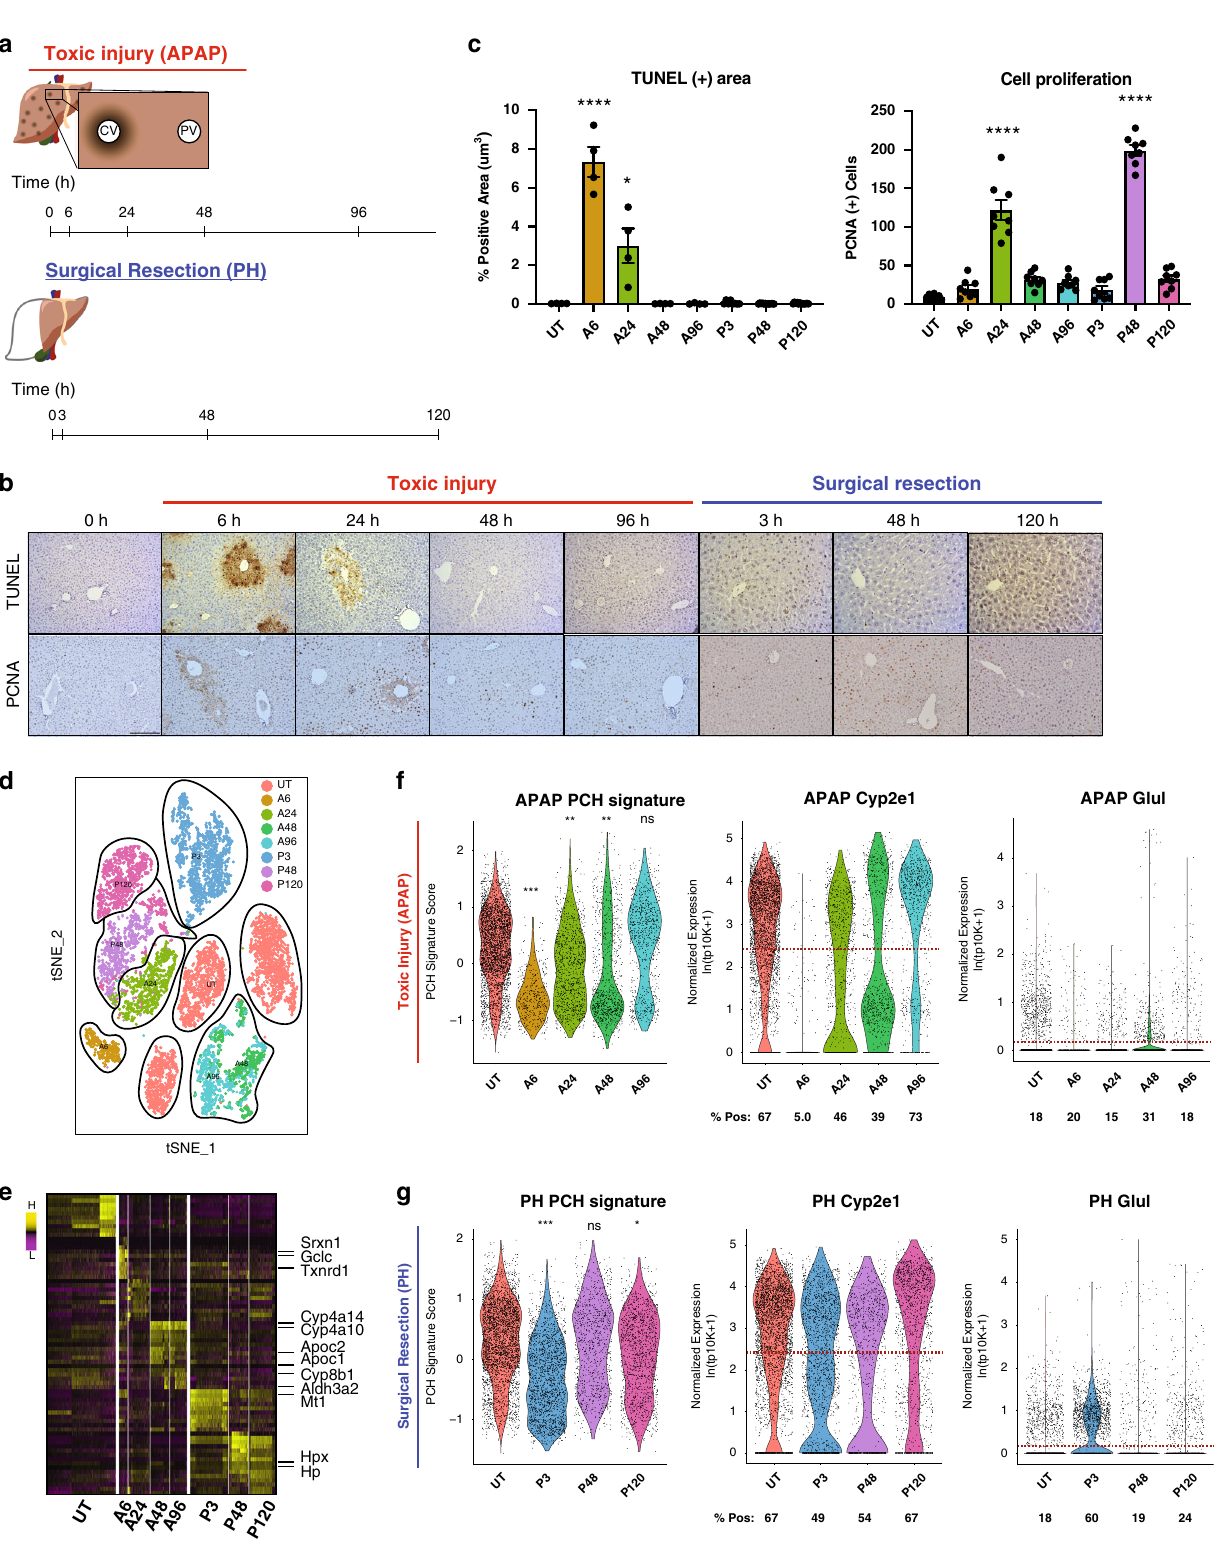
(compared to ~10% total cell loss after APAP injury), imposing extreme functional demand on remaining hepatocytes. Similarly to APAP toxicity, functional compensation was also observed after PH, evident from a dramatic increase in Glul + hepatoctyes (Fig. 1g) from 18% (Control) to 60% (P3). This is further supported by the observation that Cyp2e1 + hepatocytes